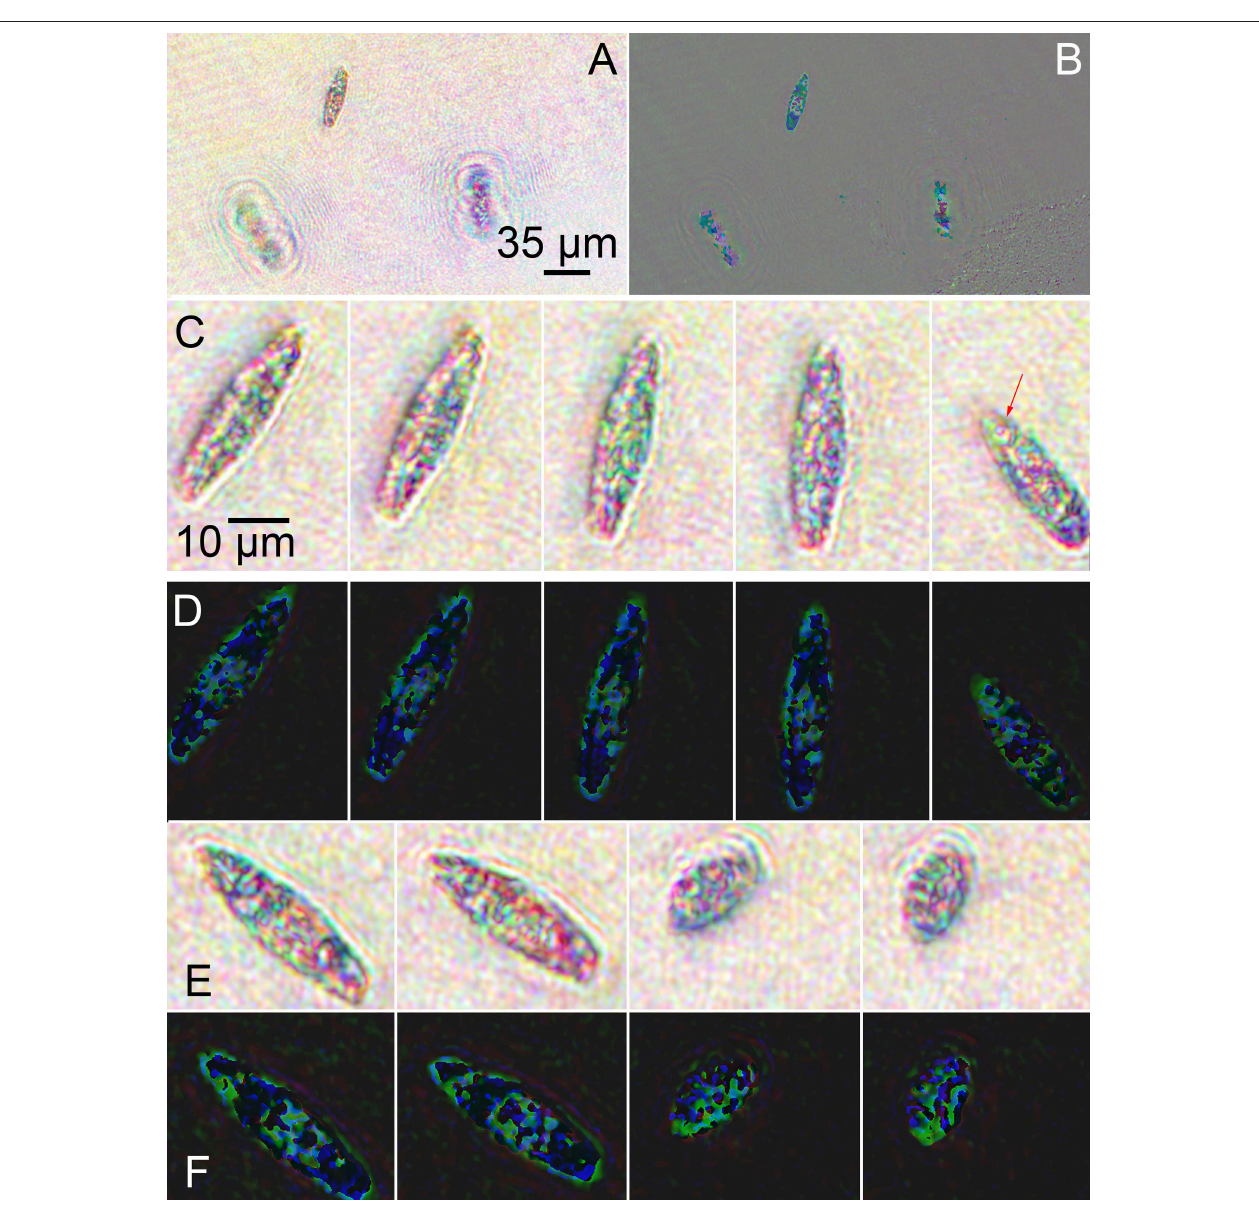
FIGURE 8 | Images of streptomycin bleached Euglena reconstructed at a single focal plane. (A) Amplitude. (B) Phase. (C) Amplitude reconstruction of a single cell rotating as it swam in x and y with minimal change in z. The arrows indicate the eyespot. Scale bar applies to all panels (C–F) . (D) Phase reconstruction of rotating cell. (E) Amplitude reconstruction of a cell contracting. (F) Phase reconstruction of contracting